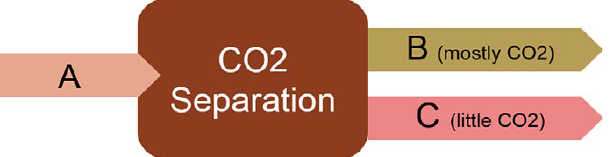
Figure 1. Diagram of the CO 2 separation process: CO 2 in the feed stream A is removed, resulting in a product stream B with more CO 2 and a product stream C with a small amount of CO 2 . Reproduced with permission from [30] .